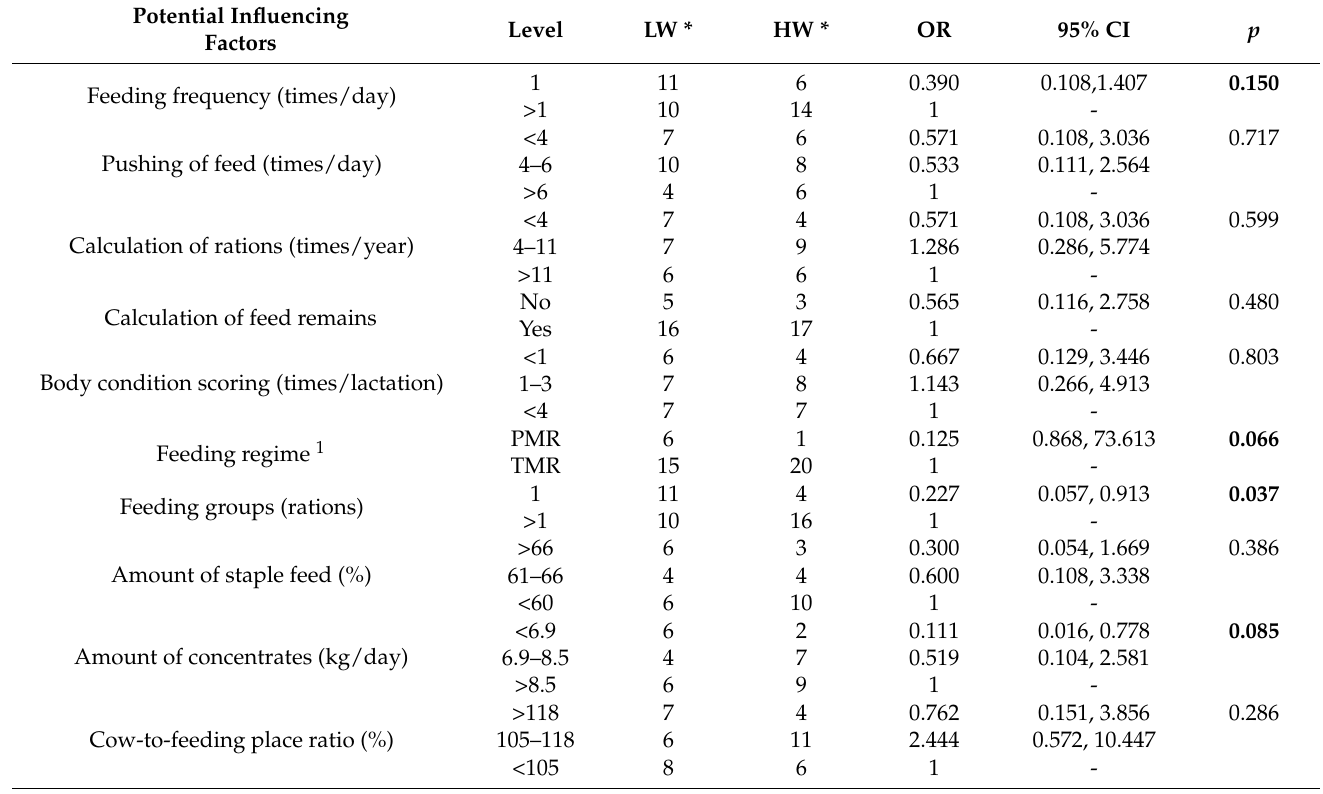
Table 4. Potential influencing factors in univariable logistic regression analysis associated with being a herd with high welfare level (HW) within the indicator “body condition score” [Odds ratio, confidence interval, bold p -values ( p < 0.20) were included in multivariable analyses; final model presented at the bottom of the table].